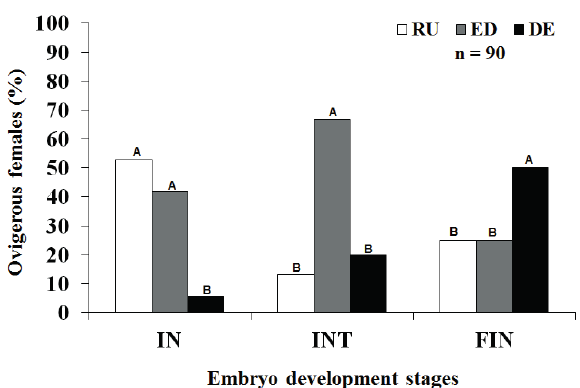
Figure 1. Eriphia gonagra (Fabricius, 1781). Ratio of ovigerous females in each gonad development stage (RU = rudimentary, ED = developing, DE = developed) compared within the groups of females in each embryo development stage (IN = initial, INT = intermediate, FIN = final). Bars with same letter did not differ statistically (Goodman’s test; α = 0.05).